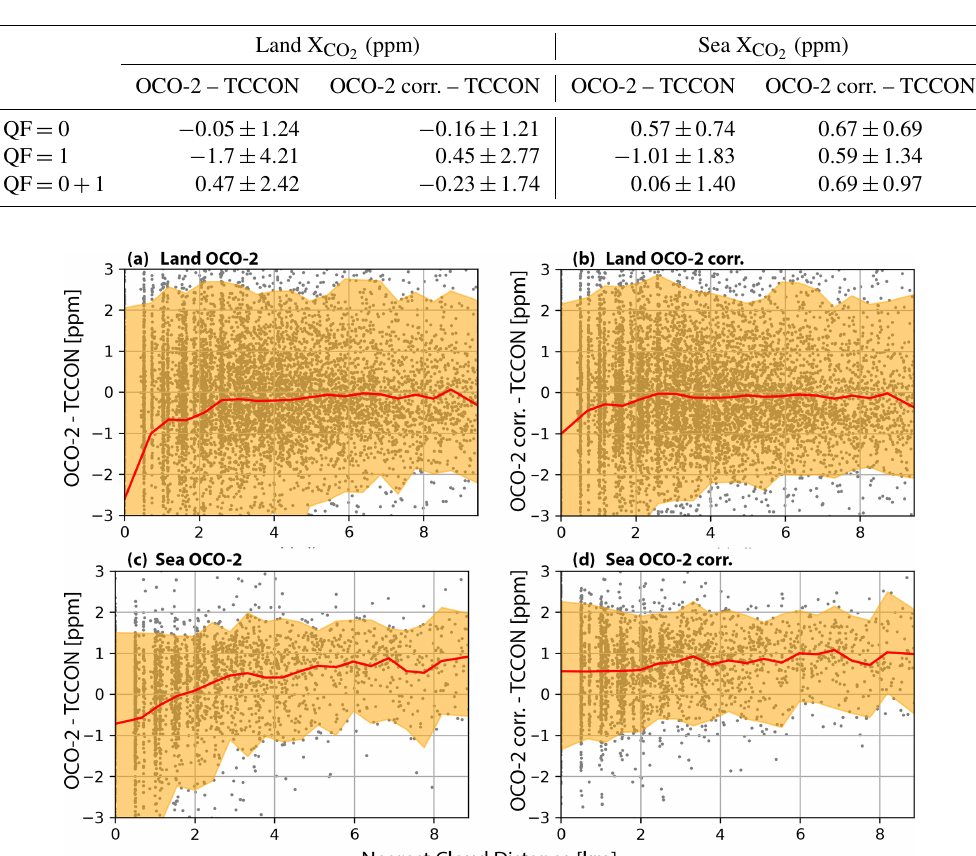
Figure 6. X CO bias vs. cloud distance of OCO-2 over land (a) , OCO-2-corrected (b) , OCO-2 over sea (c) , and OCO-2-corrected (d) for 2 QF = 0 and QF = 1 data from 2018 to 2019. The 5th and 95th percentiles are indicated by the yellow shaded area, the mean is shown with a red line, and individual comparisons are shown with gray